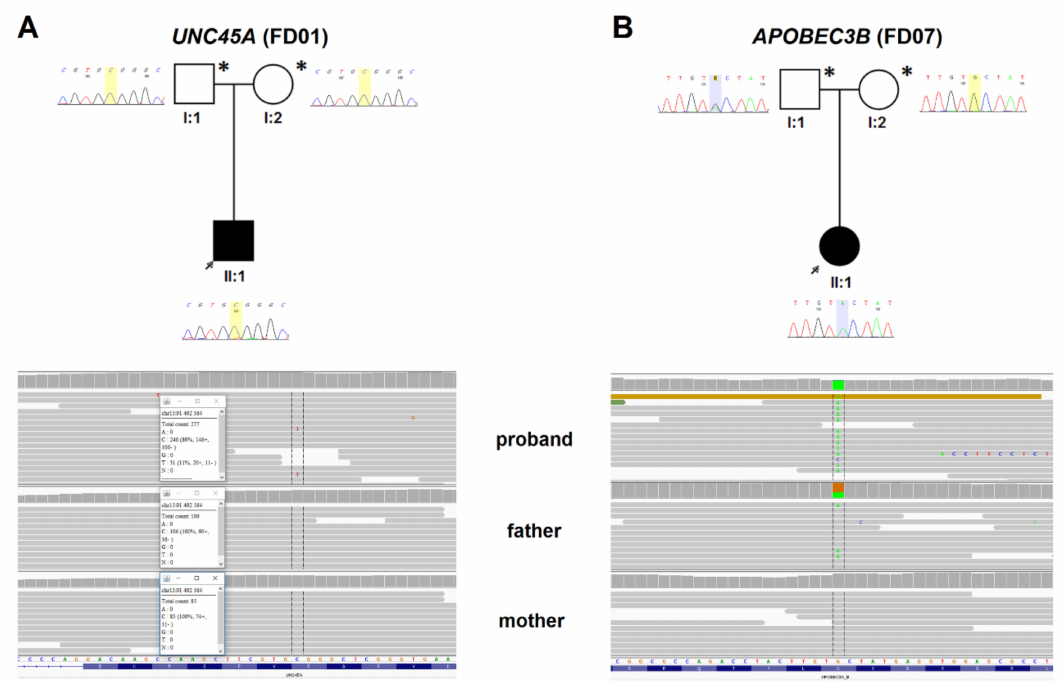
Figure 2. Pedigrees of families with other findings, corresponding Sanger chromatograms, and IGV views in trios. ( A ) UNC45A possible mosaic de novo variant p.Arg633Trp / c.1897C > T (11% of reads and corresponding lower T peak in proband’s chromatogram) (Family FD01); ( B ) APOBEC3B variant p.Cys217Tyr / c.650G > A (hemizygotic variant as a result of maternal copy deletion) (family